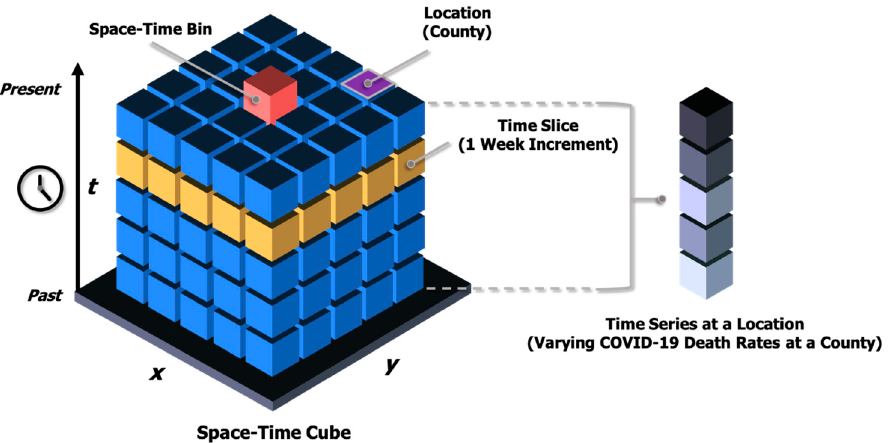
Figure 1. The structure of a space-time cube.